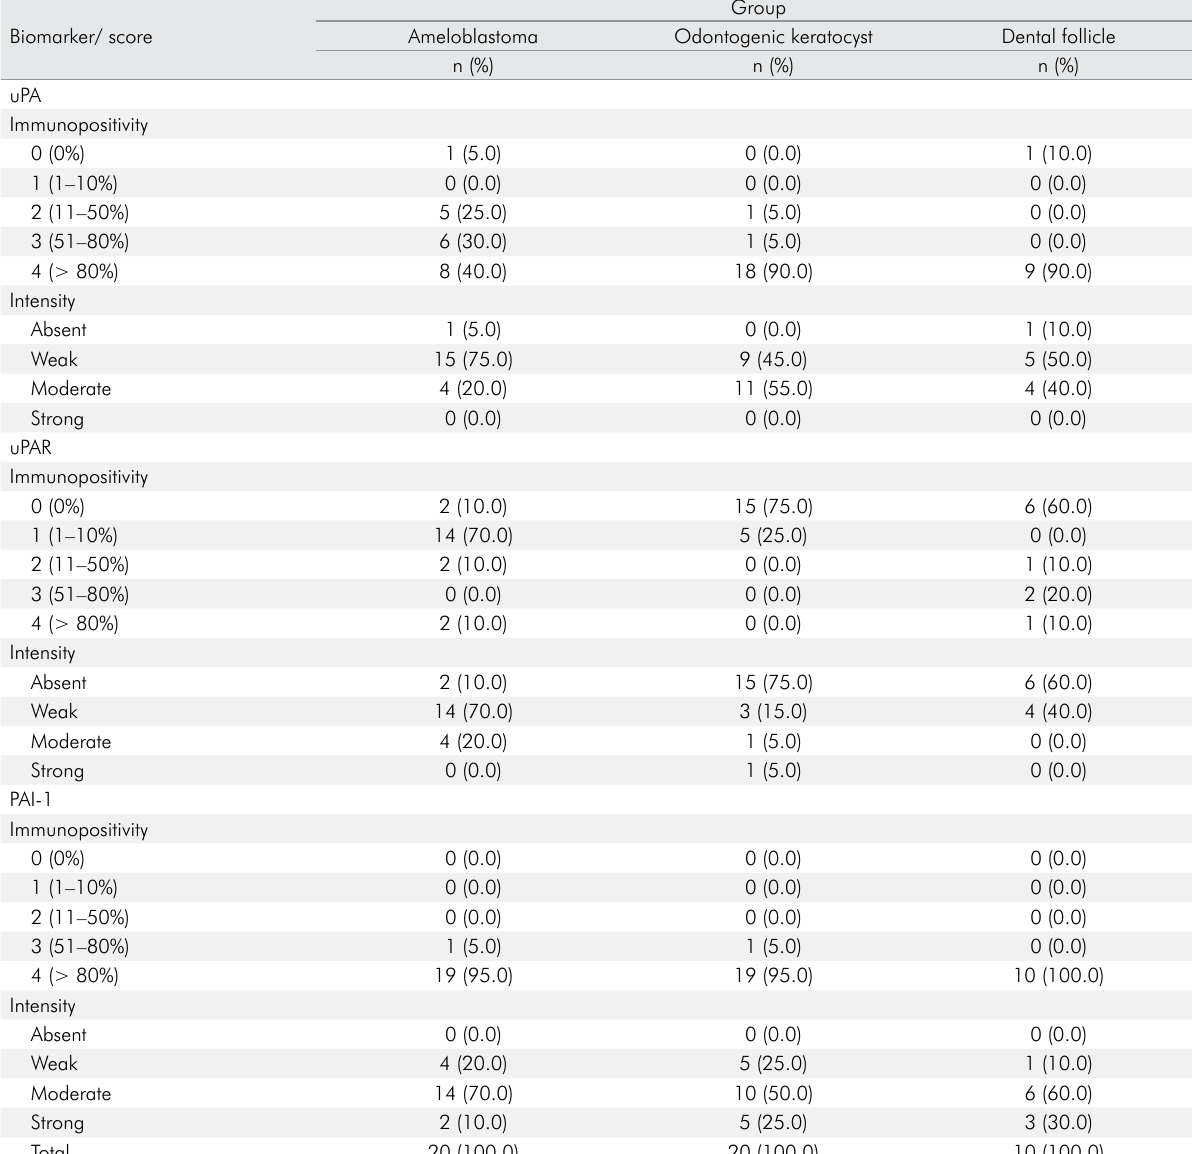
Table 1. Distribution of ameloblastomas, odontogenic keratocysts and dental follicles according to the epithelial scores of immunopositivity and intensity for uPA, uPAR and PAI-1. Biomarker/